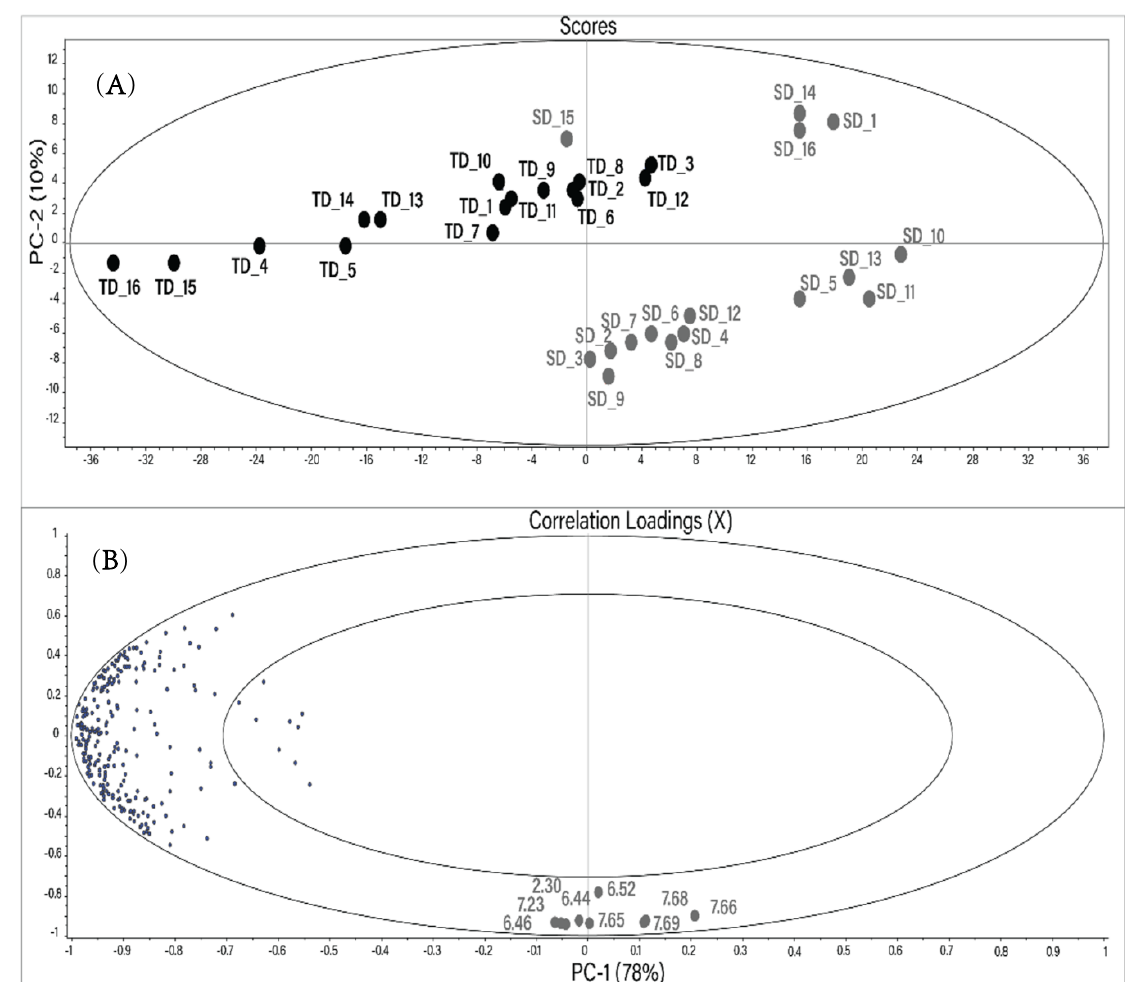
Figure 2. Score plot ( A ) and correlation loadings ( B ) of the mean-centered principal component analysis (PCA) performed using the reduced bucket table of 1 H NMR spectra of the water extracts of Hibiscus calyces. Gray: SD; black: TD. The numbers in the correlation plot indicate the chemical shift of the buckets (ppm).